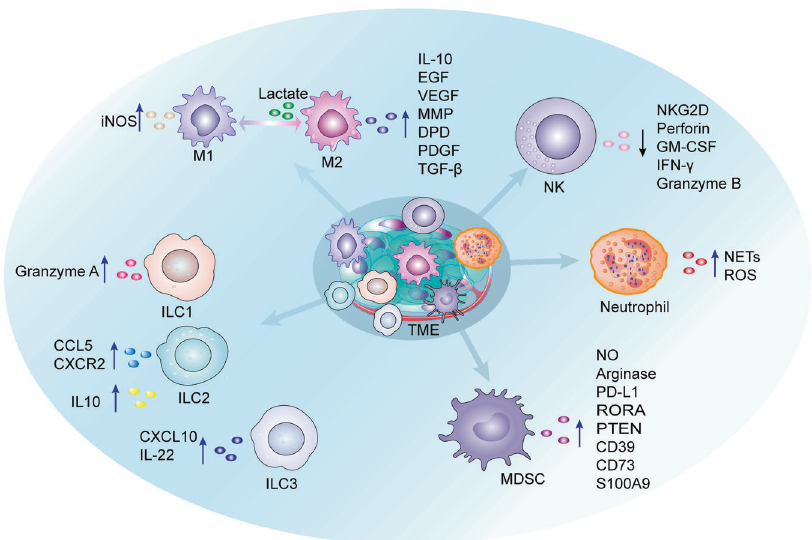
Fig. 6 Changes in cytokine secretion by innate immune cells under hypoxic conditions. M1 microphage secretes iNOS, and M2 macrophages secrete IL-10, EGF, VEGF, MMP, DPD, PDGF and TGF- β to suppress immune responses. Lactate induces M2-like polarization. HIF-1 α inhibits NK cell expression of perforin, NKG2D, GM-CSF, granzyme B and IFN- γ . Hypoxia induces neutrophils to produce ROS and NETs, which promote tumorigenesis and metastasis. HIF-1 α induces MDSCs to secrete cytokines NO, arginase, PD-L1, RORA, PTEN, CD39, CD73 and S100A9, which inhibit immune response and promote the tumor cell stemness and growth. ILC1 secretes granzyme A and maintains antitumor ef fi cacy. ILC2 enhances immune response through selective expression of CCL5, CXCR2. Hypoxia induces IL-10 expression in ILC2 and suppresses